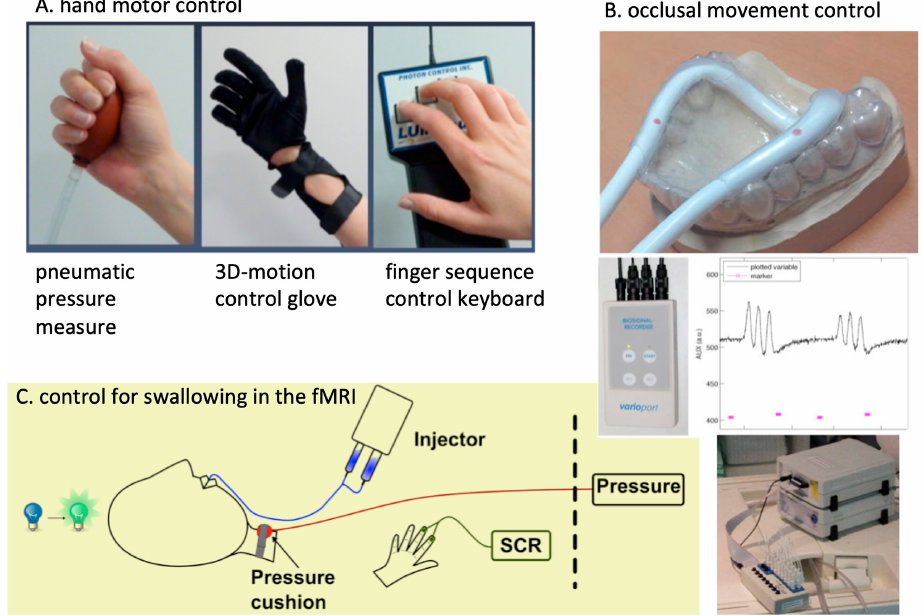
Figure 2. Control of motor performance during fMRI tasks. Left top: three possibilities to control hand motor activity: pneumatic ball, coupled with a pressure measurement device; glove, com- mercially distributed for virtual reality environments and suitable for MRI; finger sequence control keyboard. Right top: development with an individual splint for controlling occlusal pressure and frequency (see plot middle right) with the Varioport device (Varioport; Stuttgart; middle left). Bottom: control of swallowing by a pressure cushion combined with the Varioport device. Skin conductance response (SCR) can be measured with Brain Vision Analyzer 2.0 (Brain Products, Gilching, Germany; bottom right